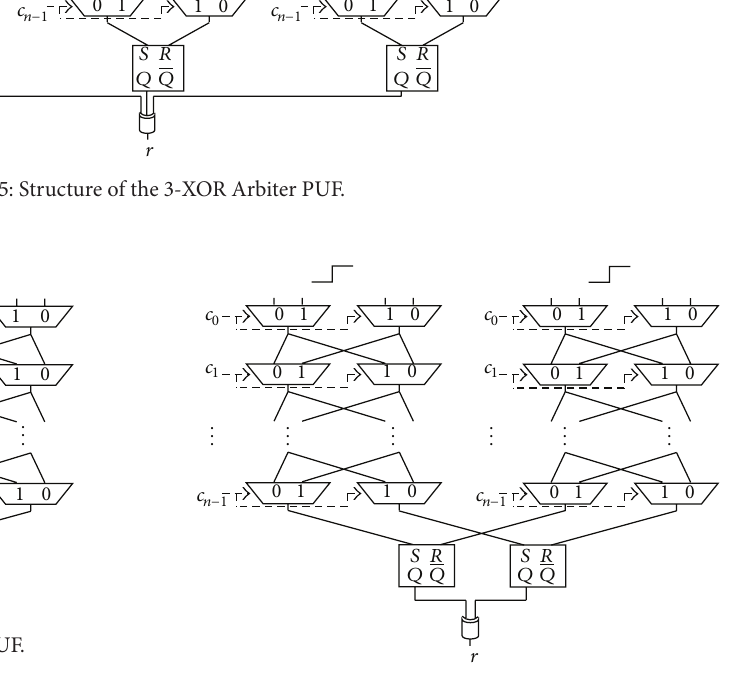
Figure 7: Structure of the 2-1 Double Arbiter